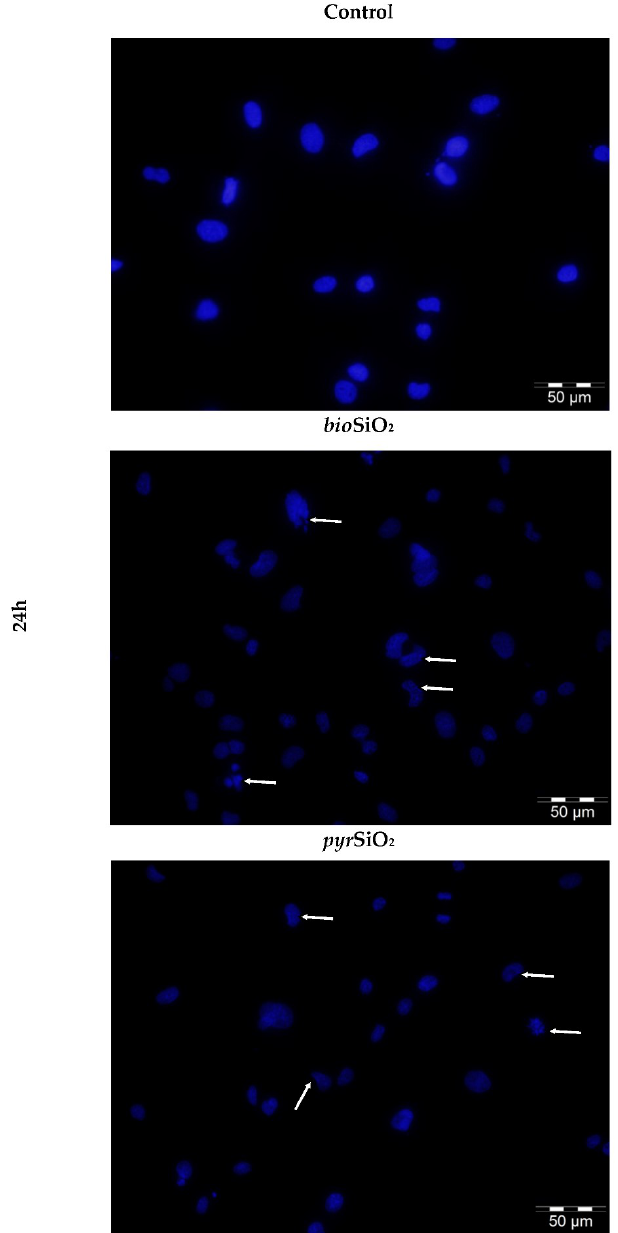
Figure 7. Cells incubated with silica nanoparticles for 24 h, seen stained for apoptosis with Hoechst 33258. Silica-nanoparticle-treatment-induced apoptosis-related morphological changes in the nuclei of HMEC-1, such as chromatin condensation and nuclear fragmentation, were marked with a white arrow ( → ). Olympus BX51 fluorescence microscope, 400 × . Scale bar: 50 µ